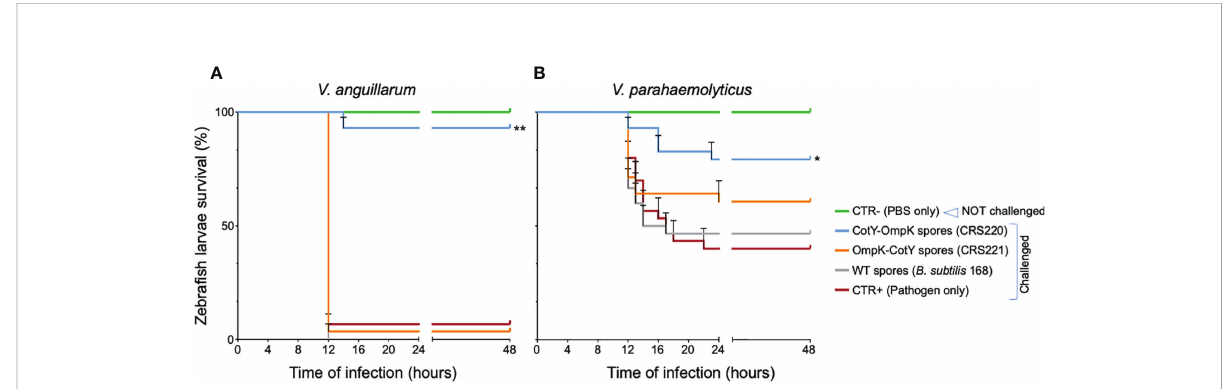
FIGURE 2 Zebra fi sh larvae survival to V. anguillarum and V. parahaemolyticus infection, after exposure by immersion to OmpK carrying spores. Kaplan- Meyer survival curves of zebra fi sh larvae upon challenge with V. anguillarum (A) or V. parahaemolyticus (B) , three days after being vaccinated with spores from B subtilis 168 (WT) or its congenic derivatives bearing the OmpK antigen fused to CotY, namely strains CRS220 (CotY-H6- OmpK) and CRS221 (H6-OmpK-CotY). Non-vaccinated larvae (CTR+, pathogen only) and non-challenged larvae (CTR-, PBS only) were used as positive and negative control groups, respectively. Larvae were monitored for 48 hours. Data are represented as mean ± standard deviation of three independent biological experiments. Signi fi cant differences are highlighted by asterisks: * ( p <0.05) or ** ( p